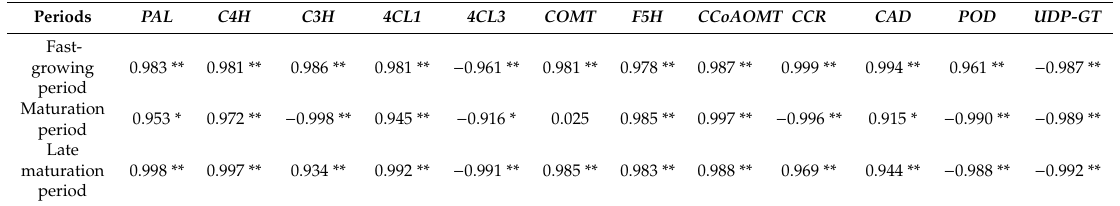
Table 4. Correlation coefficients of lignin content and its related key genes expression.